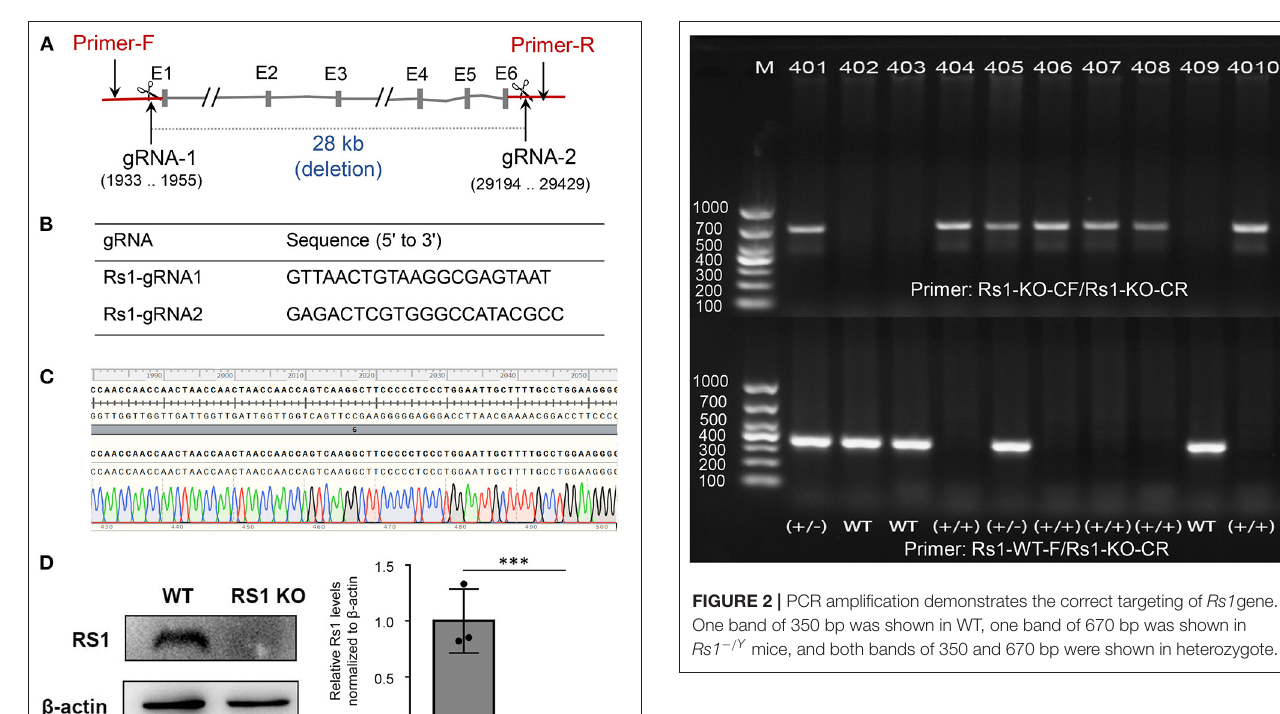
intensities. The a ′ wave amplitude of Rs1 − / Y mice (0 log cd-s/m 2 )